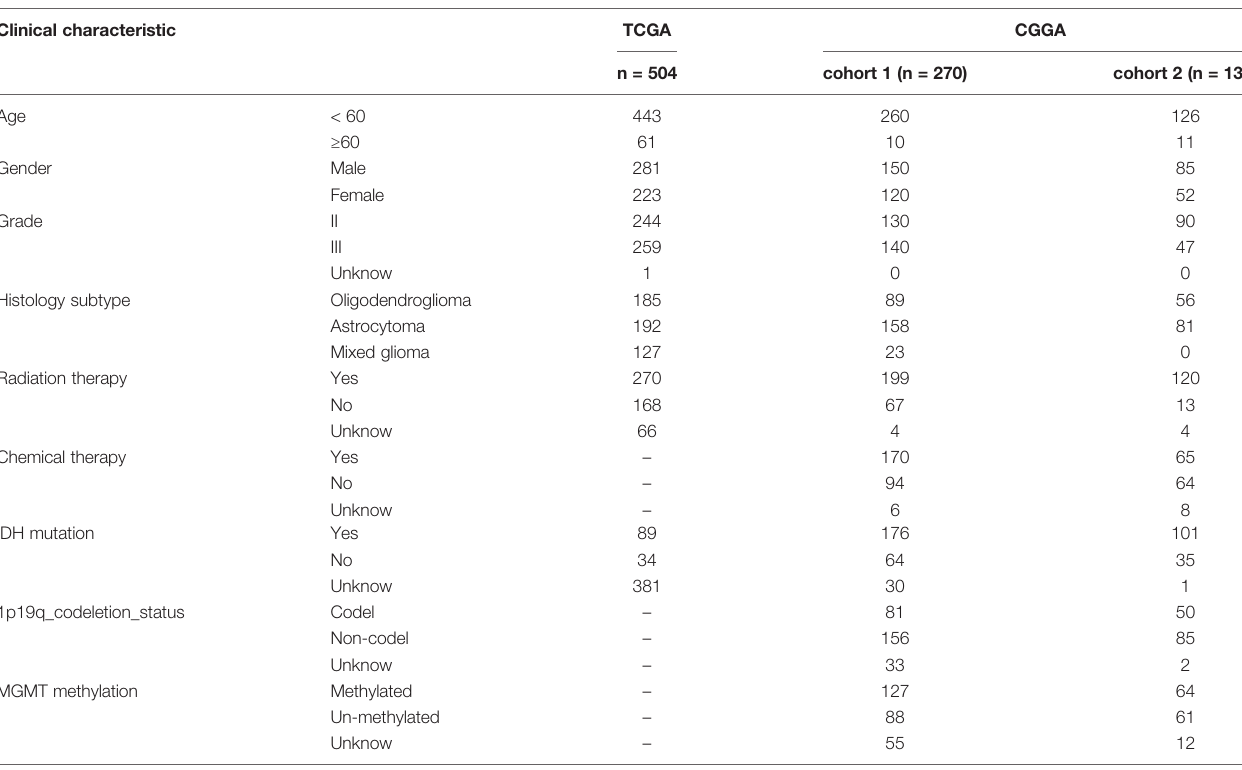
TABLE 1 | Clinical characteristics of the primary lower-grade gliomas.